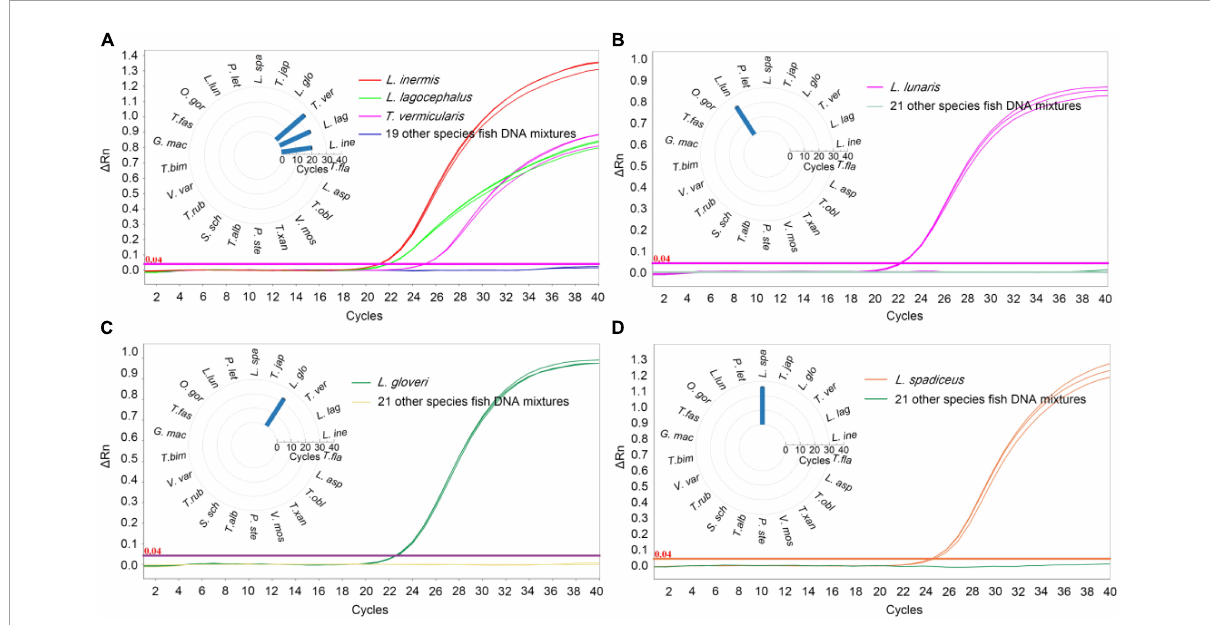
FIGURE2 Specificity results of real-time qPCR methods. qPCR Ct value corresponding to puffer fish and other meat DNA, (A) L. inermis , L. lagocephalus , and T. vermicularis was detected and the Ct value was 20.58 ± 0.09, 22.61 ± 0.24, and 25.43 ± 0.11, respectively. Other 19 species fish were undetected. (B) L. gloveri was detected and the Ct value was 22.71 ± 0.38. (C) L. lunaris was detected and the Ct value was 22.99 ± 0.47. (D) L. spadiceus was detected and the Ct value was 25.98 ± 0.28. Inner: the Ct value for the samples with 22 species of fish. L. ine , Lagocephalus inermis ; L. lag , Lagocephalus lagocephalus ; T. ver , Takifugu vermicularis ; L. glo , Lagocephalus gloveri ; T. jap , Trachurus japonicus ; L. spa , Lagocephalus spadiceus ; P. let , Paralichthys lethostigma ; L. lun , Lagocephalus lunaris ; O. gor , Oncorhynchus gorbuscha ; T. fas , Takifugu fasciatus ; G. mac , Gadus macrocephalus ; T. bim , Takifugu bimaculatus ; V. var , Verasper variegatus ; T. rub , Takifugu rubripes ; S. sch , Sebastes schlegelii ; T. alb , Takifugu alboplumbeus ; P. ste , Platichthys stellatus ; V. mos , Verasper moseri ; T. xan , Takifugu xanthopterus ; T. obl ,